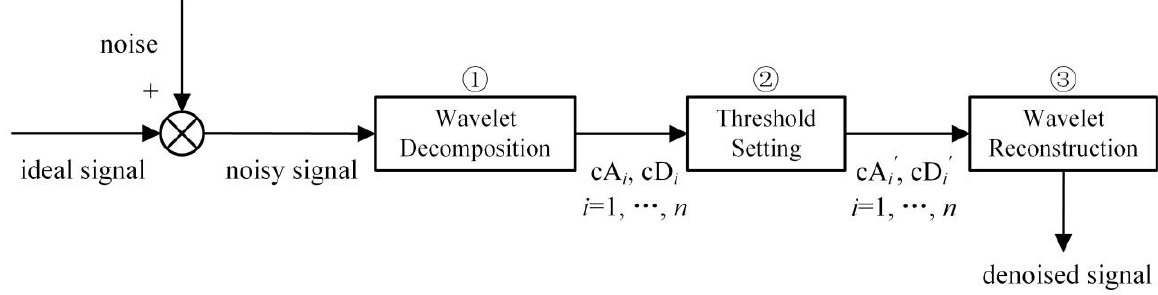
Figure 2. Wavelet threshold denoising